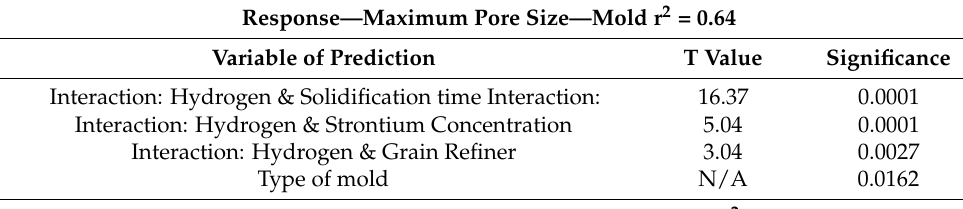
Table 1. Prediction parameters for maximum pore size using the statistical reduction technique.